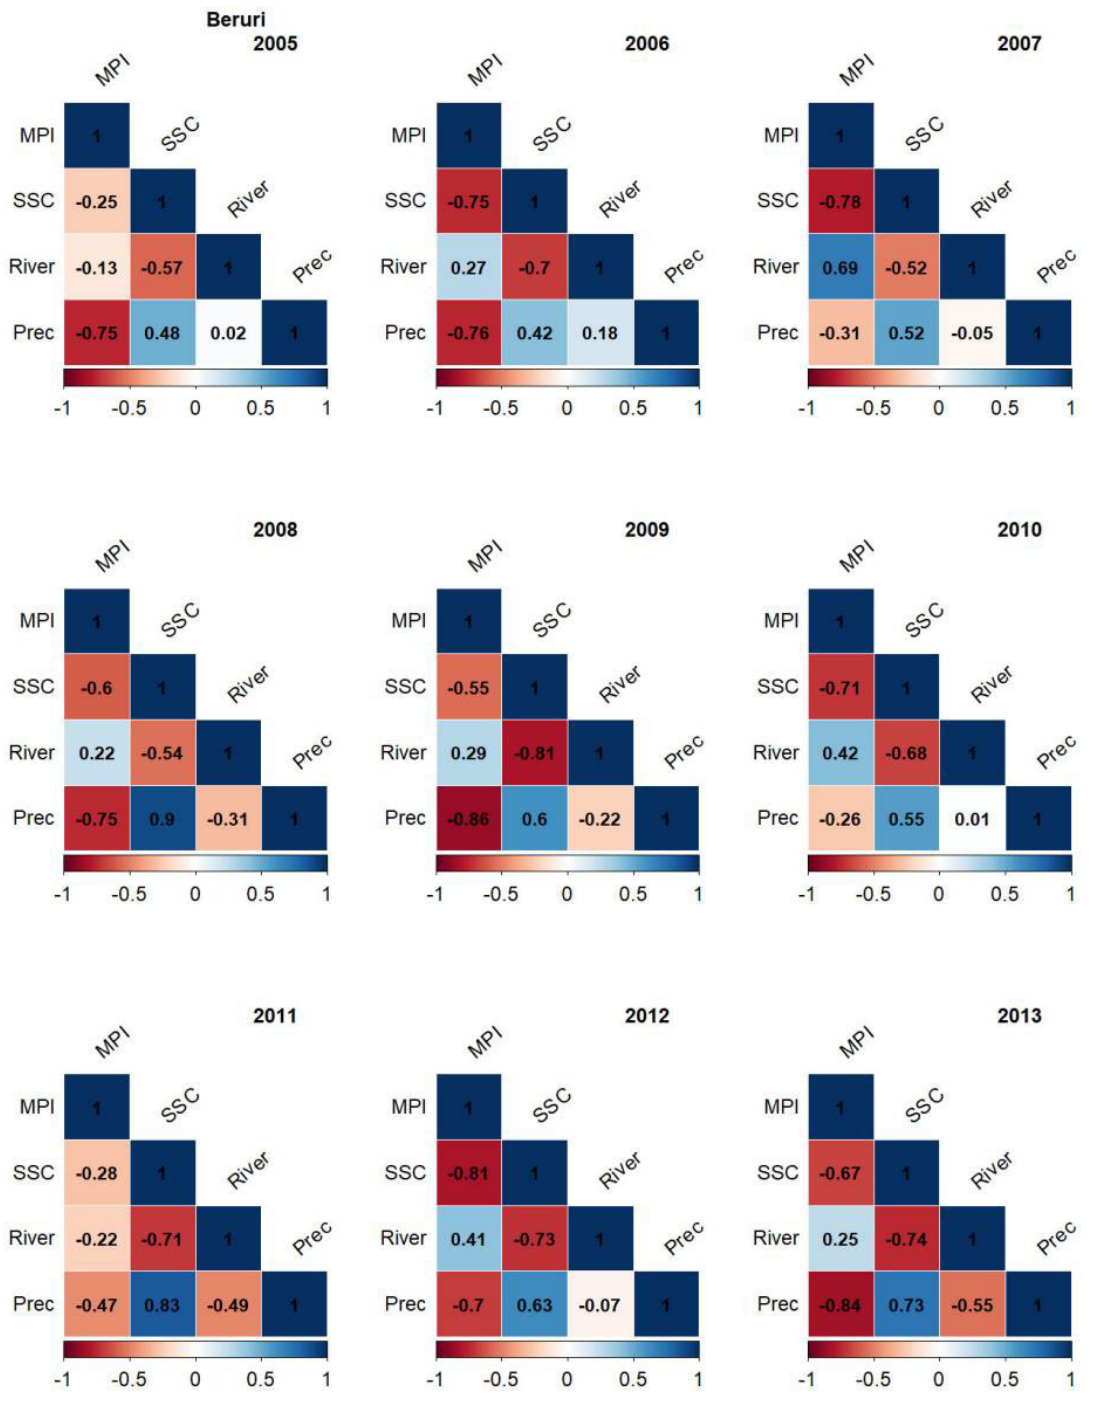
Figure 4. For the municipality of Beruri, the relationship between monthly malaria parasite index (MPI), of suspended sediment concentration in rivers (SSC), river level (River), and precipitation (Prec), during the period 2005–2013.